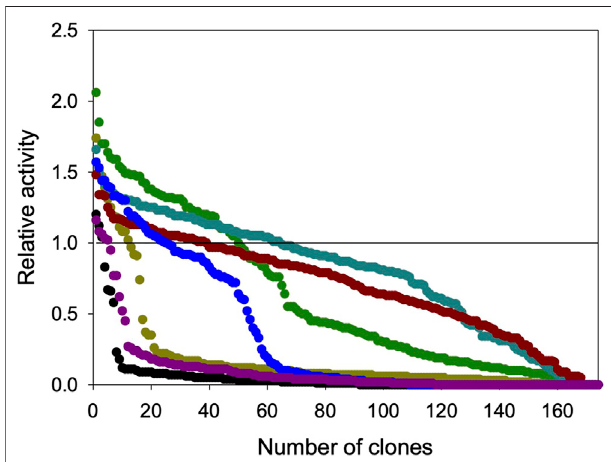
FIGURE 5 | Mutagenic landscapes of GroGu for the N -dealkylation of the NNBT model scaffold. The solid horizontal line shows the activity of the parental GroGu in the assay. The activities of the individual clones are plotted in descending order: Black circles, Condition I (Taq polymerase, 0.15 mM MnCl 2 ); yellow circles, Condition II (Taq polymerase, 0.10 mM MnCl 2 ); green circles, Condition III (Taq polymerase, 0.015 mM MnCl 2 ); light blue circles, Condition IV (Taq polymerase, 0.010 mM MnCl 2 ); red circles, Condition V (Taq polymerase, 0.005 mM MnCl 2 ); purple circles, Condition VI (GeneMorph II, 30 cycles); blue circles, Condition VII (GeneMorph II, 20 cycles).